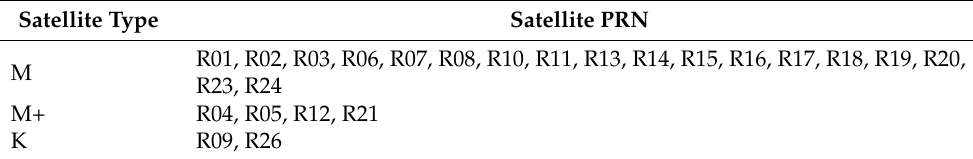
Table 1. Constellation of GLONASS (as of November 2022). There are 18 M satellites, 4 M+ satellites, and 2 K